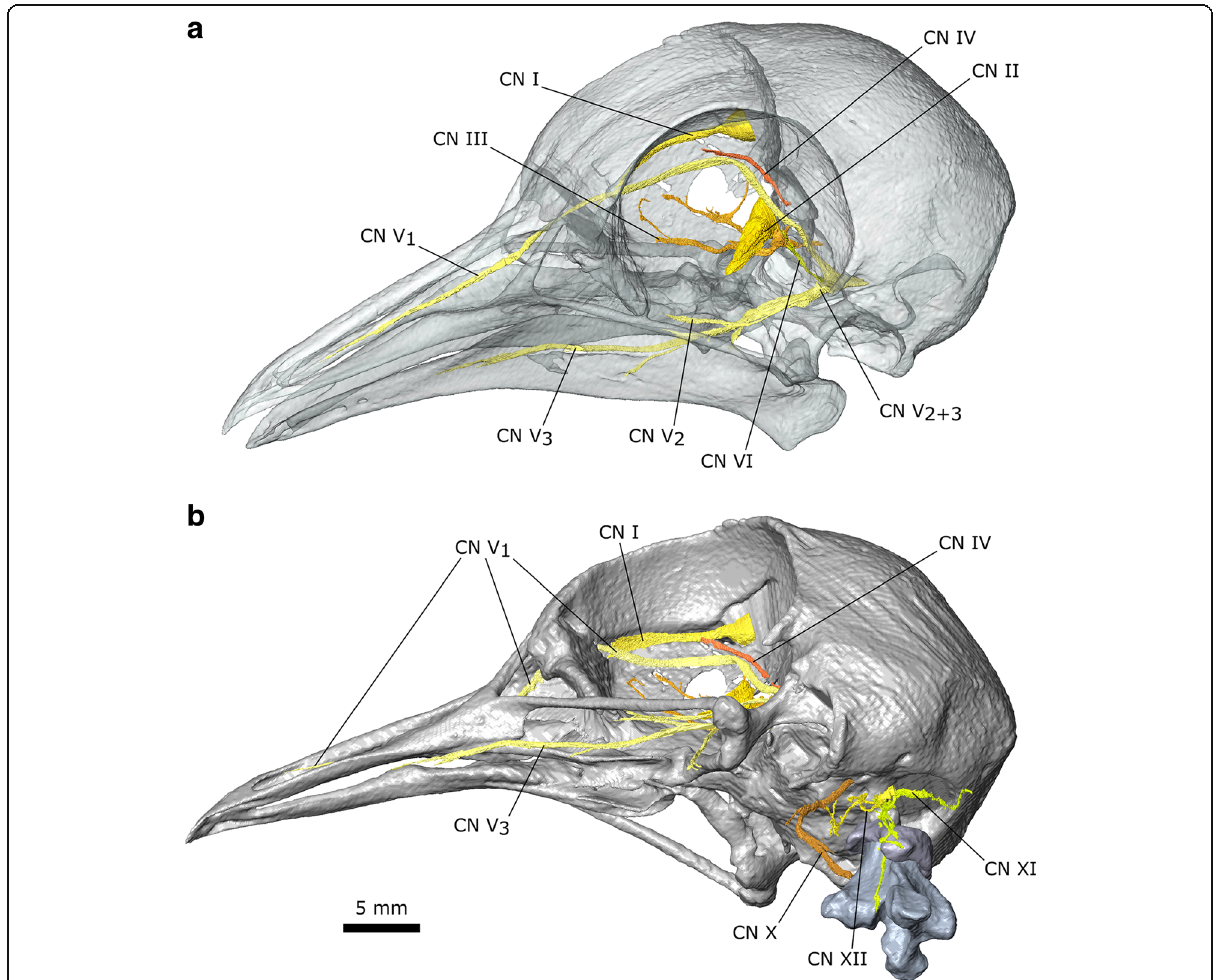
Fig. 4 Cranial nerves of Columba livia . a dorsolateral view of the cranium and lower jaw with bone partly transparent. b ventrolateral view of the cranium, atlas, and